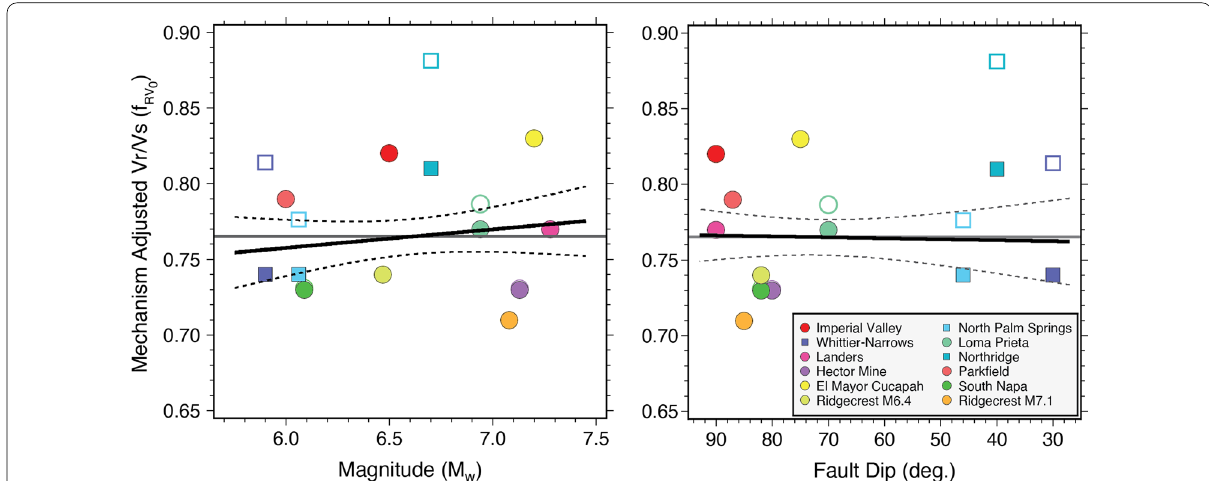
Fig. 15 Same as the bottom row of Fig. 12 except here I plot f RV 0 , which are the input values prior to any mechanism adjustment. The open symbols are the f RV values then used in the rupture generator, and are determined by dividing the f RV0 by the mechanism scaling factor a T (Eq. 8). Note that the adjustment is negligible for primarily strike-slip events (dip ≥ 75°) so the open symbols for these events plot beneath the filled